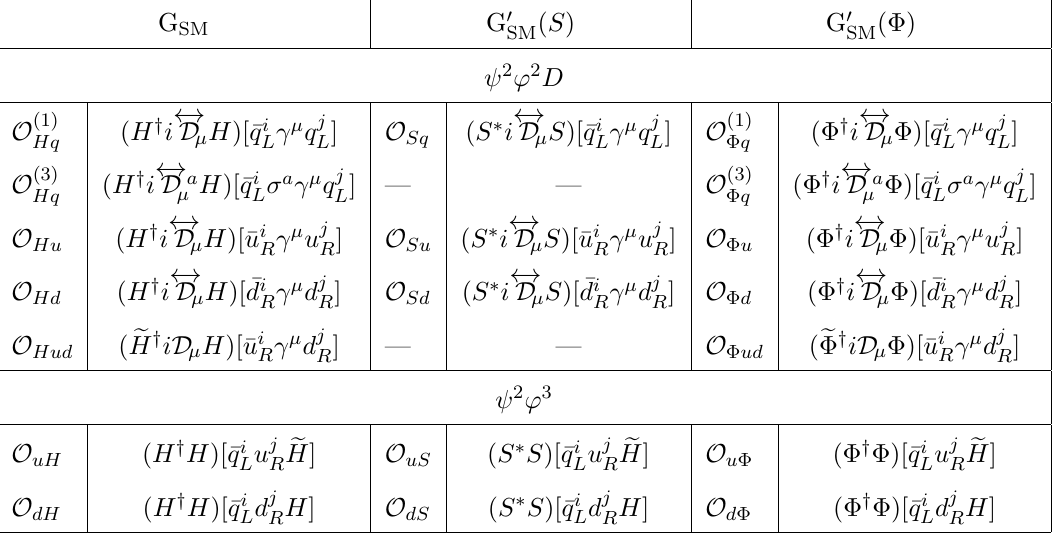
Table 2. We follow the de(cid:12)nitions of [26] for 2 ’ 2 D operators, except for the signs of gauge couplings in the covariant derivatives, and ( 2 ’ 3 + h.c.) operators in the case of G SM models and extend them to G 0 ( S ) and G 0 ((cid:8))-models ( ’ = H; S; (cid:8)). Superindices i; j = 1 ; 2 ; 3 on quark SM SM (cid:12)elds denote the generations. These are all operators that could arise from tree-level decoupling of VLQs, depending on the